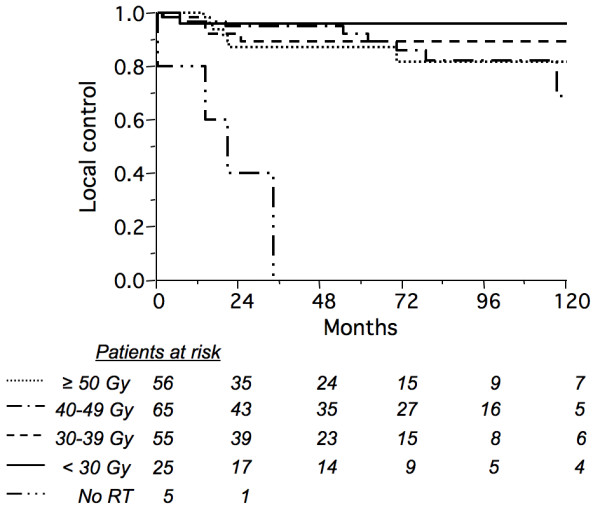
Actuarial local control rate according to biologically equivalent dose at 2 Gy per fraction (no radiation therapy: solid/double-dot line; <30 Gy: solid line; 30–39 Gy: dashed line; 40–49 Gy: solid/single-dot line; = 50 Gy: dotted line) in 206 patients with solitary bone plasmacytoma (p < 0.0001 but not significant when excluding non irradiated patients).